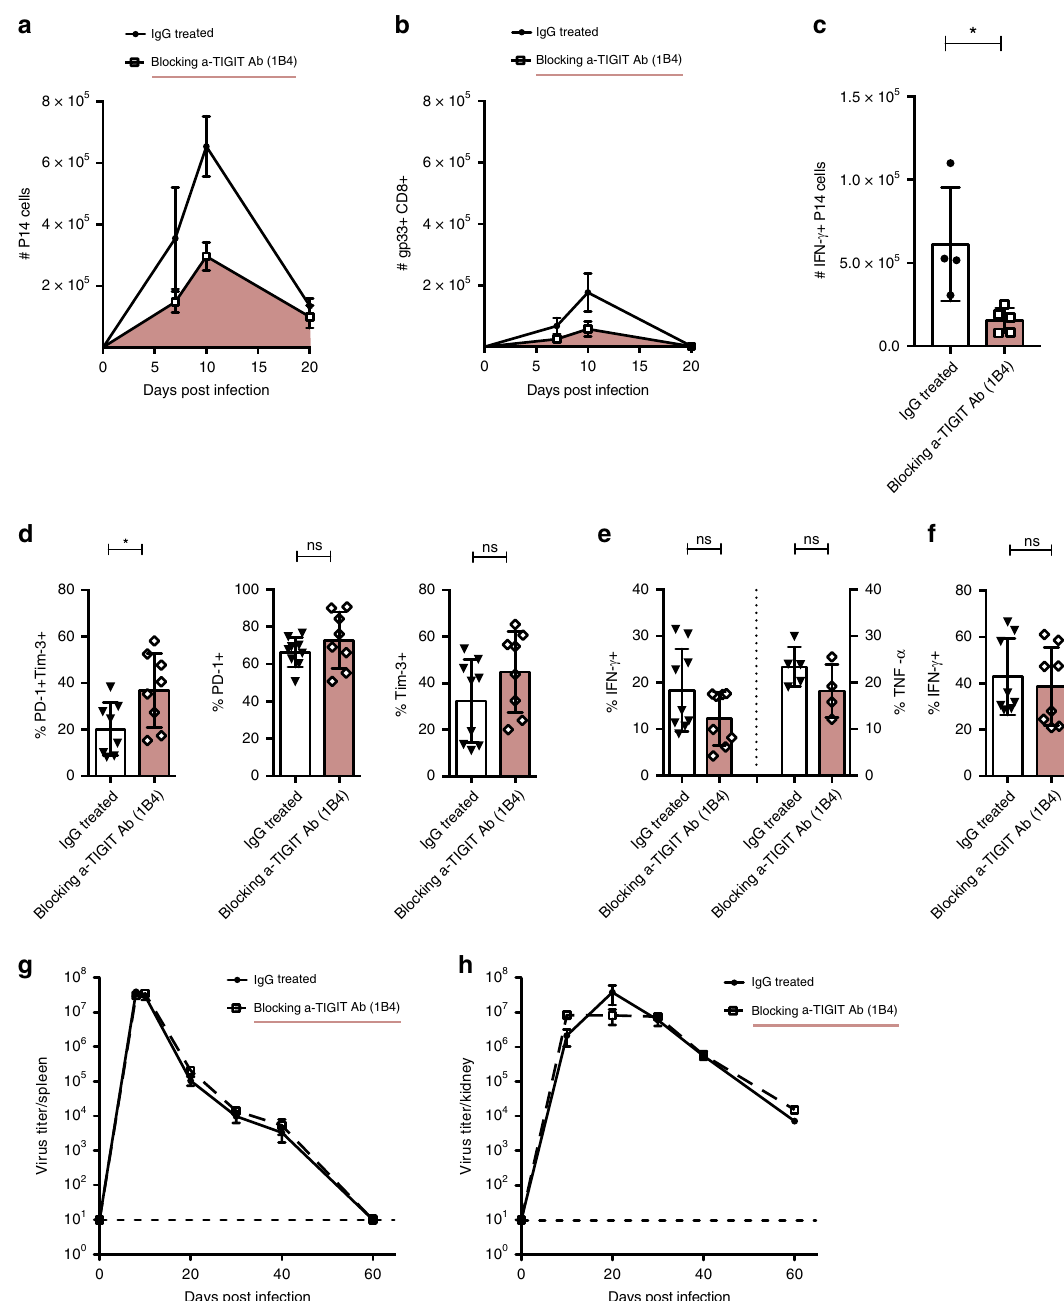
Fig. 5 Loss of virus-speci fi c T cells after TIGIT blockade during chronic LCMV infection. 10 ’ 000 Ly5.1 + P14 cells were transferred i.v. one day prior to chronic LCMV clone 13 infection and treatment with 100 μ g of anti-TIGIT (1B4) Ab or mouse IgG1 i.p. FACS quanti fi cation of ( a ) absolute numbers of P14 Ly5.1 + TCR transgenic CD8 + T cells ( n = 4 – 5) and ( b ) antigen-speci fi c CD8 + T cells by peptide/MHCI tetramer staining against gp33 ( n = 4 – 5) in the blood. c Absolute numbers of IFN- γ producing P14 cells on day 10 were measured by FACS, (spleen, n = 4 – 5). d PD-1 and Tim-3 expression on P14